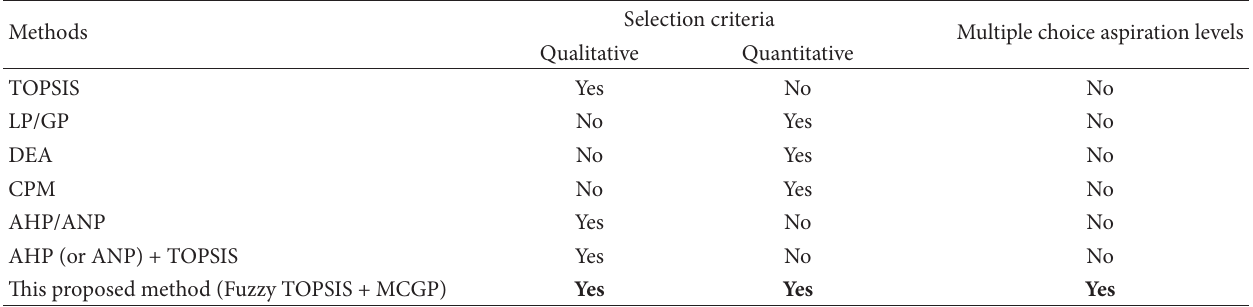
Table 13: Comparison of logistics centers location selection